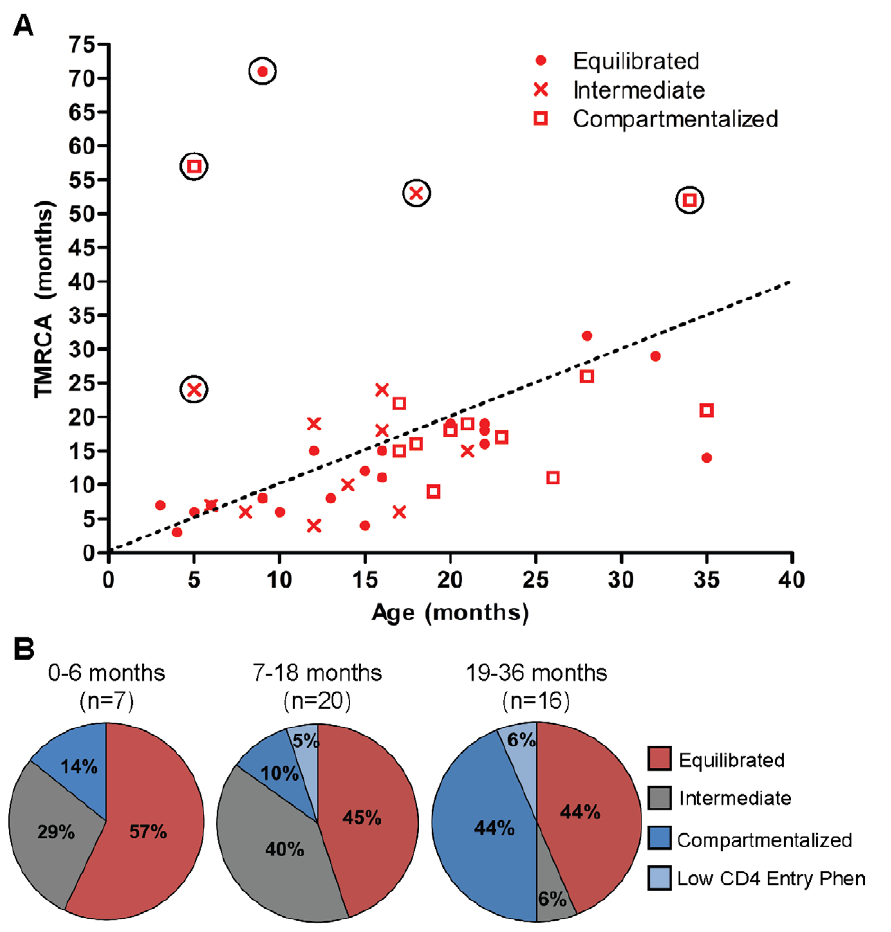
Figure 3. Evolutionary history of HIV-1 populations within the first three years of pediatric CNS infection. Age and TMRCA comparisons over the first three years of life. (a) Relationship between age of subjects and TMRCA of plasma population determined by BEAST [33]. Concordance of age and TMRCA indicated by dotted line. TMRCA outliers are indicated by open circle; equilibrated, subject 4055; intermediate, subjects 3017 and 4048; compartmentalized, subjects 3002 and 4004. (b) Pie charts grouping the children by age and showing the percentage of children in each state as a function of time. Phen, phenotype.